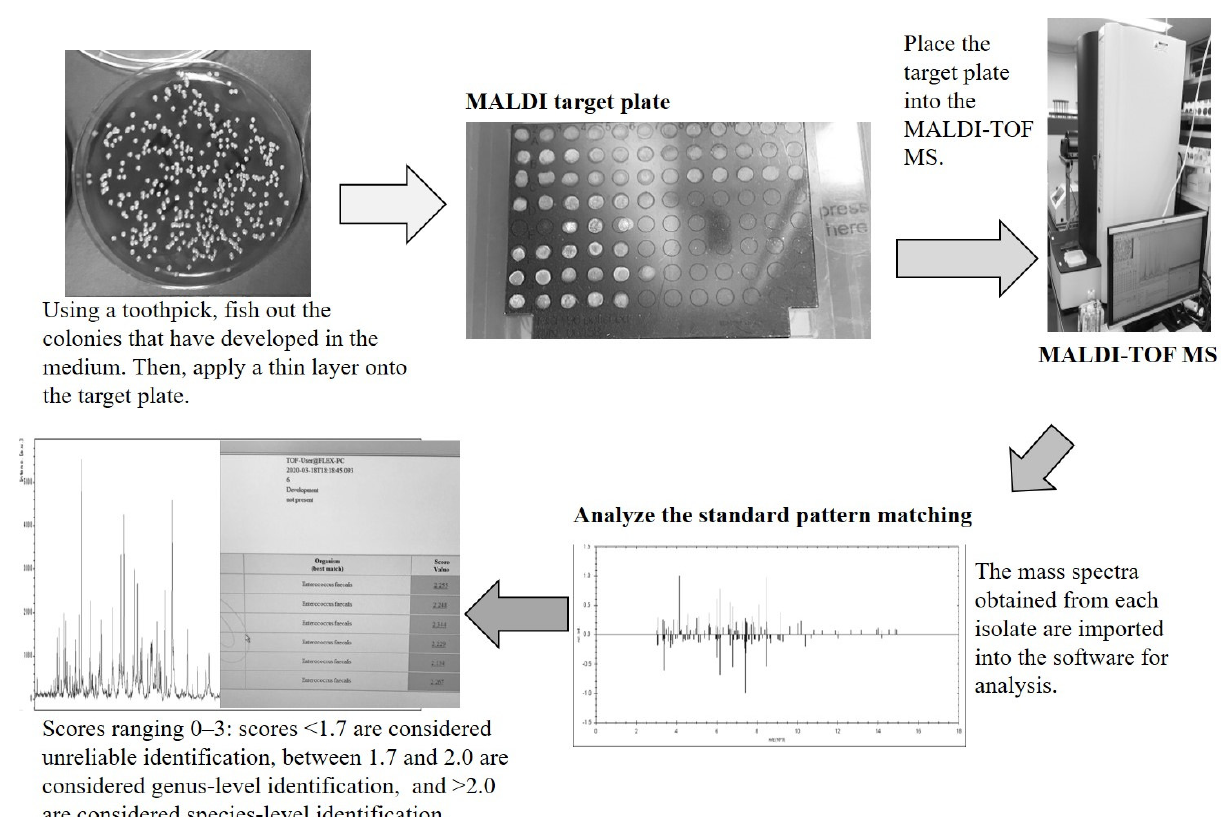
Figure 2. Flow of bacterial identification by MALDI-TOF MS (example using MALDI Biotyper ® ). For identification by mass spectrometry (MS), (1) the colony is applied to a MALDI sample plate to be irradiated with a laser. The MALDI matrix is added and dried, and the MALDI sample plate is inserted into the mass spectrometer. (2) The mass spectrometer irradiates the MALDI sample plate with a laser to ionize the proteins (mainly ribosomal proteins) in the bacteria, and the mass spectral pattern is obtained from the mass/charge ratio ( m / z ) of the constituent proteins and the intensity from the time of flight to the detector. (3) The obtained MALDI mass spectrum pattern is compared to a database for identification. The MALDI matrix used for bacterial identification is typically α -cyano-4-hydroxycinnamic acid (CHCA), which works by (1) absorbing laser energy efficiently, (2) supplying protons to the sample and promoting ionization, and (3) preventing sample decomposition.